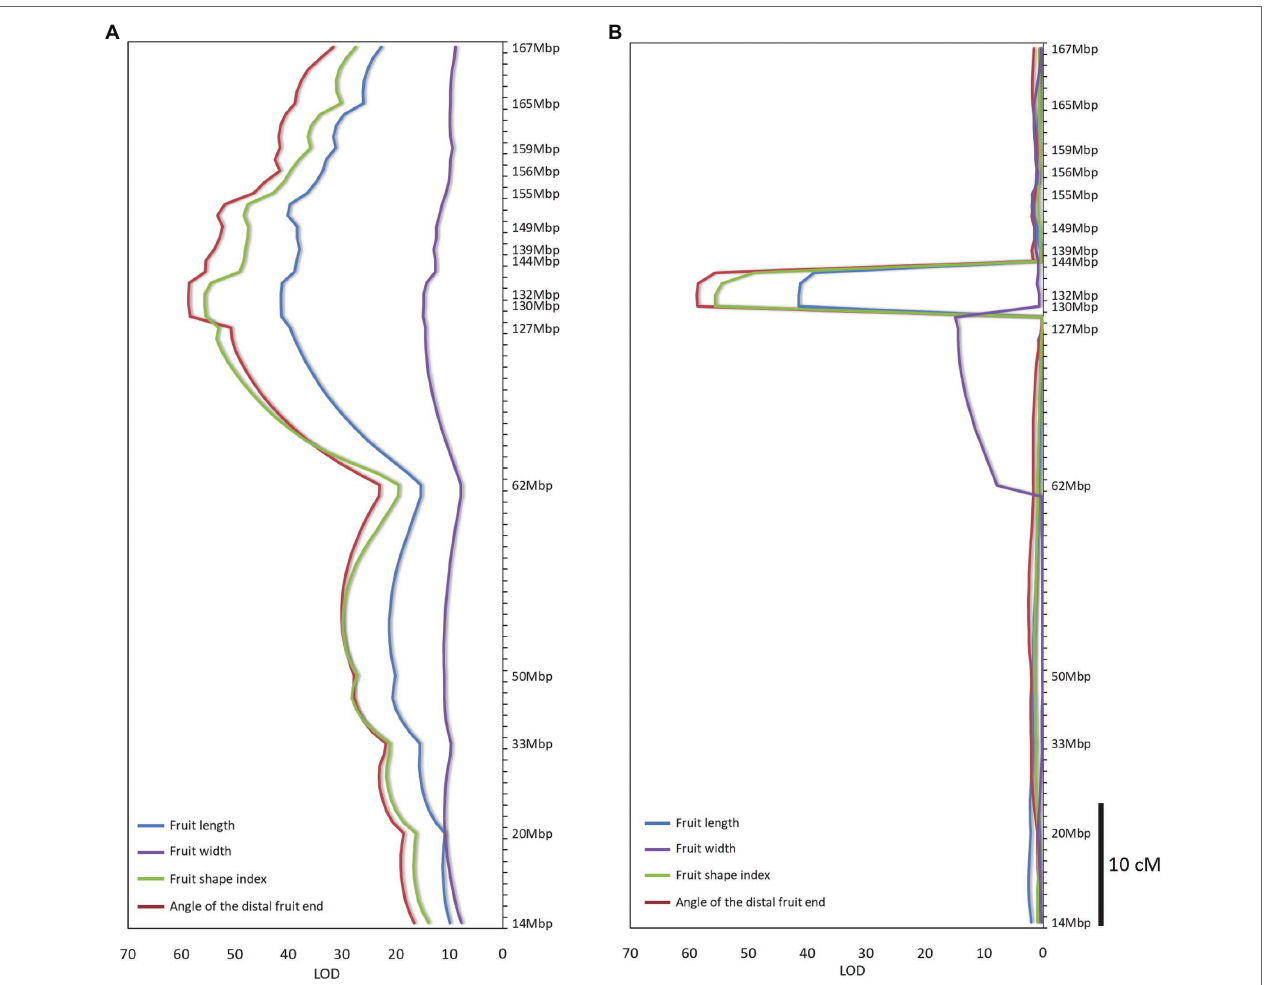
FIGURE 3 | QTL mapping of fruit shape parameters in the F 2 population. (A) Interval mapping. (B) MQM mapping. Significance threshold of LOD = 2.2 ( p = 0.05) was determined for QTL detection by permutation test. Mapping analyses were performed by MapQTL software version 5 (Kyazma B.V., Netherlands).